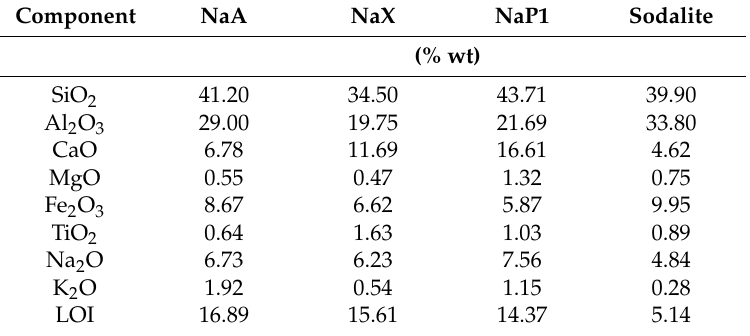
Table 4. Analyses of the chemical compositions of the samples with their main zeolite components given in the